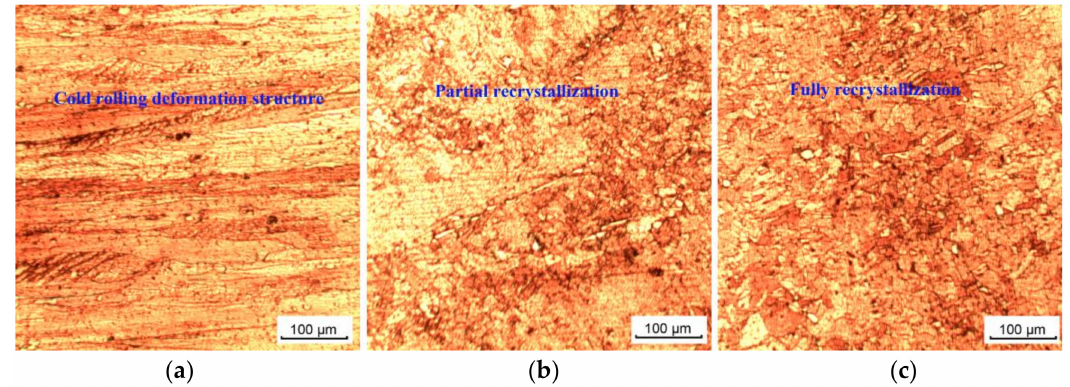
Figure 3. Optical microscopy (OM) micrographs of Cu-Cr-Zr alloys with 240-min-aged initial states at ( a ) 723 K, and 60-min-annealed states at different temperatures of ( b ) 873 K and ( c ) 973